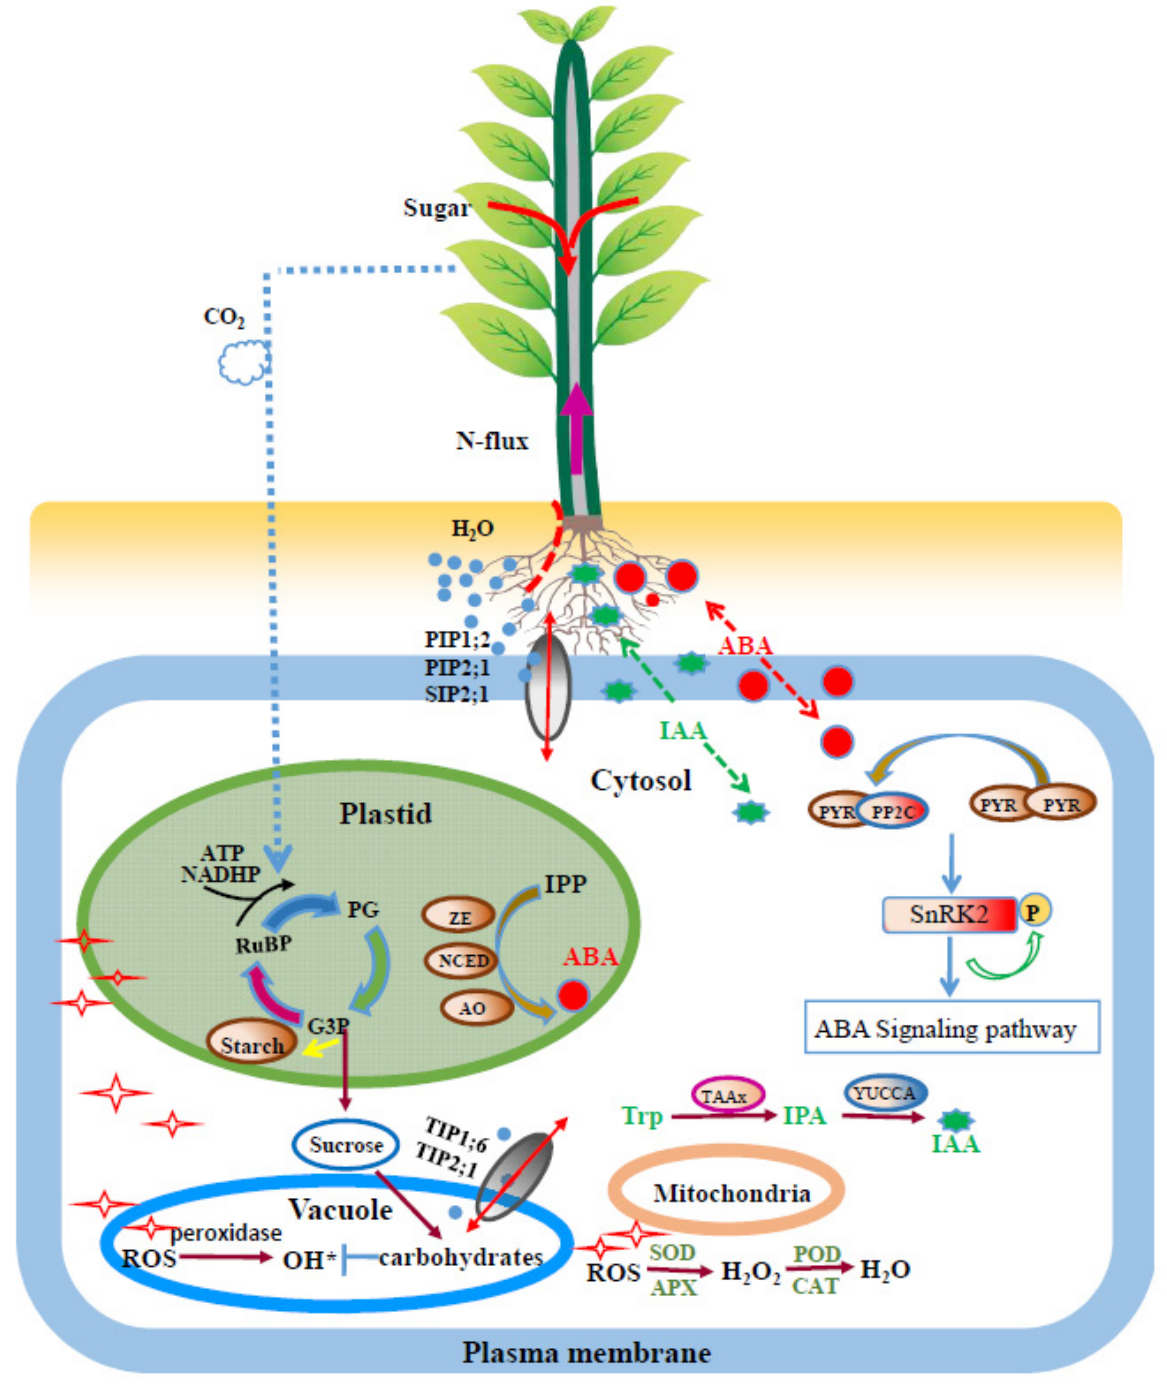
Figure 9. A schematic model of responses to nitrogen supply in Populus simonii under drought stress. While acclimating to drought, the P. simonii exhibited a reduction in growth; a decrease in the photosynthetic rate and transpiration rate; and an increase in δ 15 N, soluble substances, ROS scavenging; and water use efficiency. Strong response in the transcriptional regulation of AQPs ; higher soluble phenolics; lower transpiration rates, IAA and ABA content, and ROS accumulation and scavenging were observed with a sufficient N